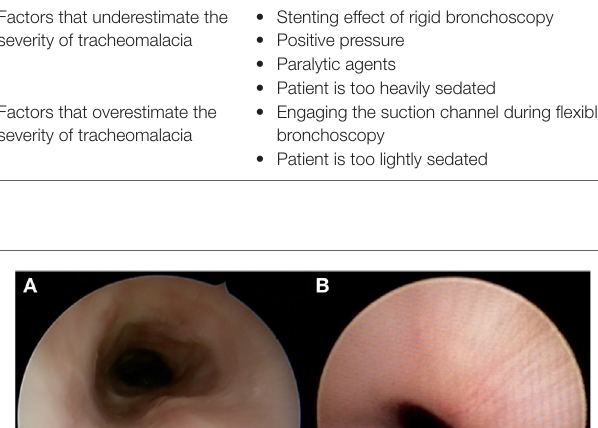
TAble 2 | Confounding factors associated with the bronchoscopic assessment of tracheomalacia. Factors that underestimate the severity of